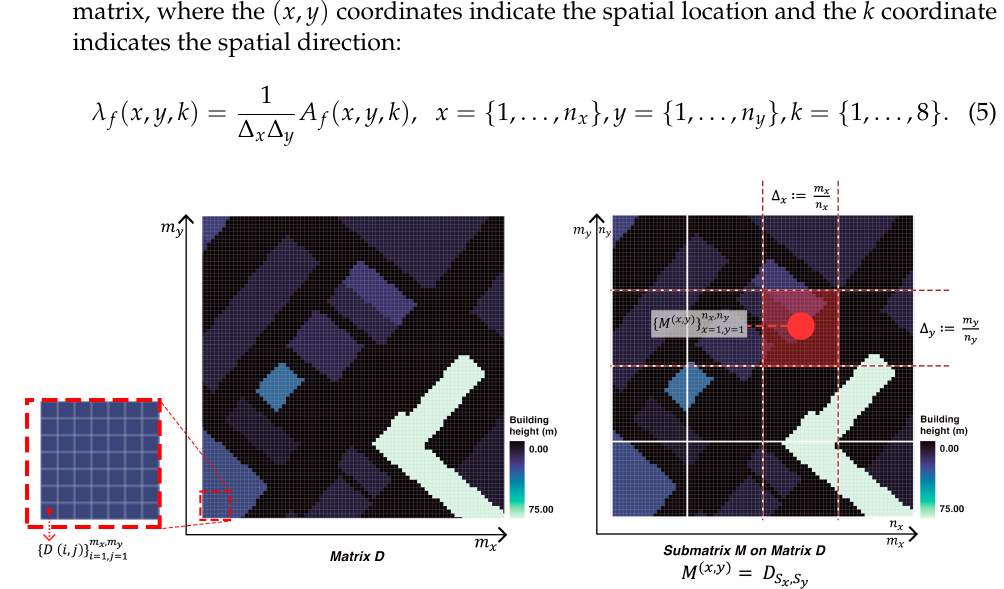
Figure 2. Left : Input dataset with spatial resolution of 1 × 1 m 2 . Right : Spatial partitioning into a set n x , n y of matrices { M ( x , y ) } . x = 1, y = 1